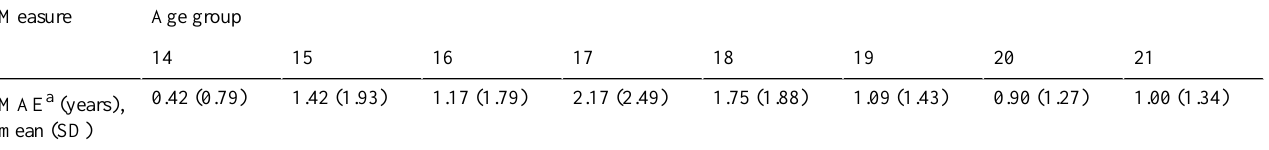
Table 15. Mean absolute error and standard deviation for the male median